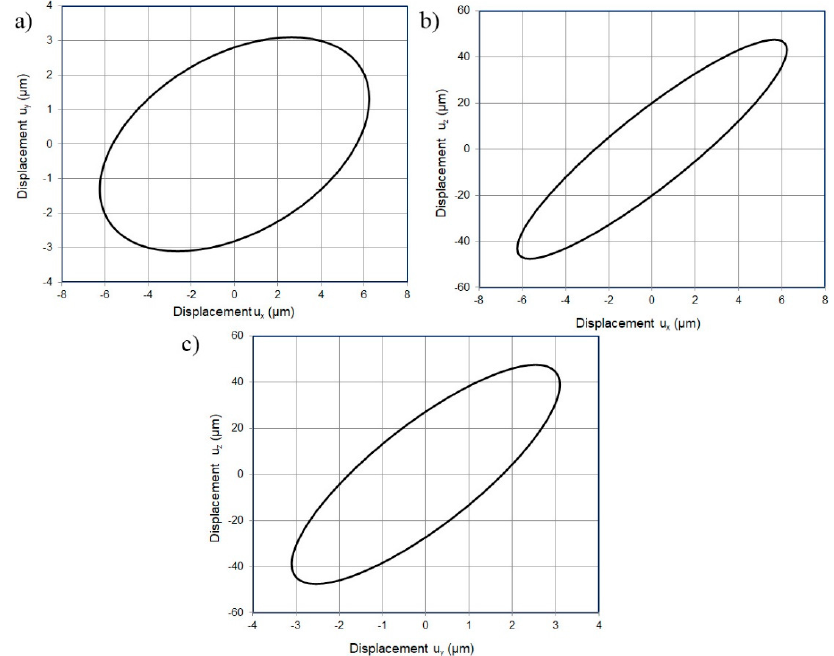
Figure 6. Displacement trajectories of the contact point: (a) in the XY plane; (b) in the XZ plane; (c) in the YZ plane.